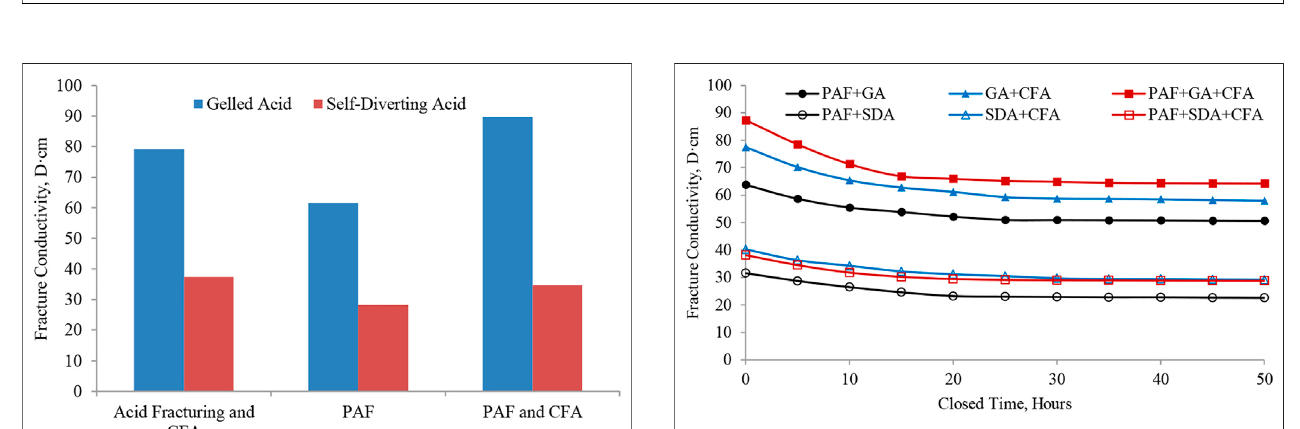
FIGURE 6 | Acid-etched fracture conductivity of Qixia Fm, Sichuan Basin. (A) Effect of closure stress; (B) effect of temperature; (C) effect of the acid injection rate; and (D) effect of acid volume.